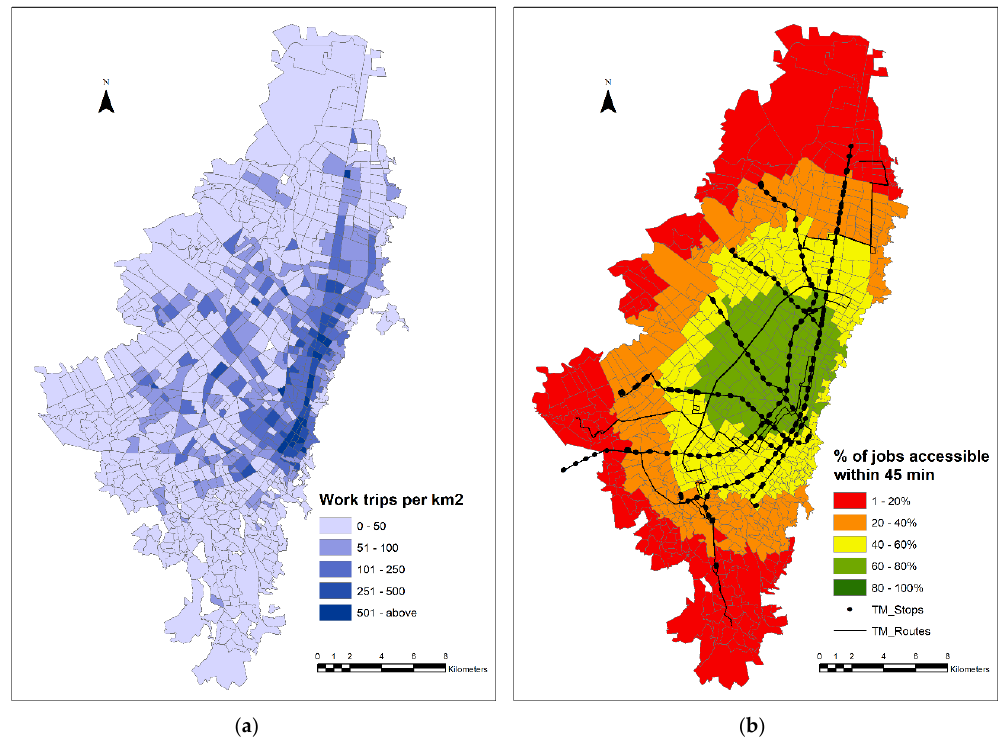
Figure 4. The number of job destinations of survey respondents by zone per km 2 ( a ) and the % of jobs that is accessible within 45 min from each Transport Analysis Zone (TAZ) ( b